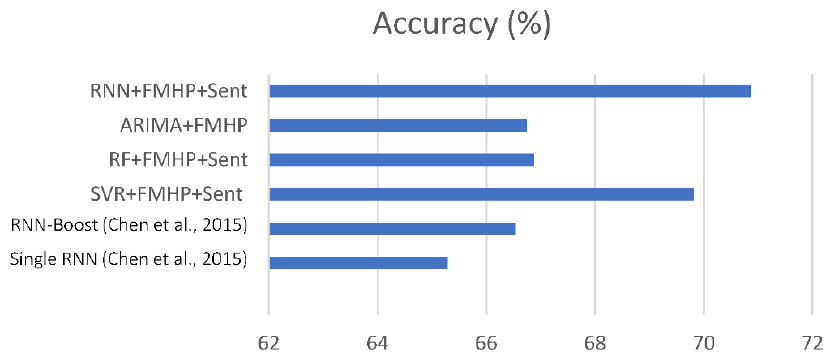
Figure 11. Comparison of accuracy of the proposed model with Chen et al. [14]. RMSE score of 2.05 achieved by Chen et al. Figure 12 shows a visual comparison of our models with their models.